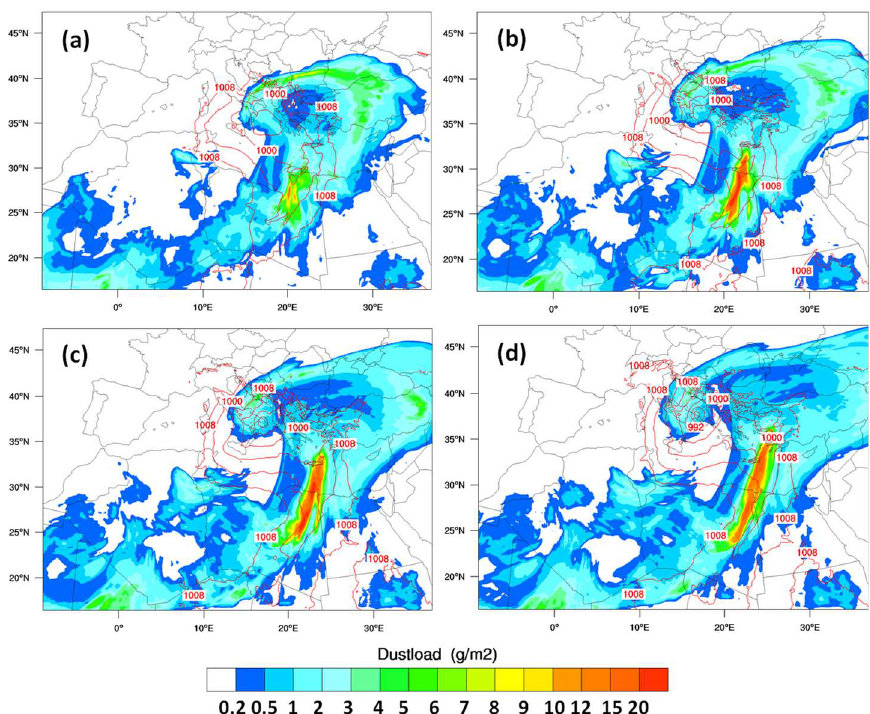
Figure 6. Dustload (mg m −2 ) and slp (red contours every 4 hPa) on 22 March 2018: ( a ) 0900 UTC; ( b ) 1200 UTC; ( c ) 1500 UTC; ( d ) 1800 UTC (dust transport along the warm conveyor belt).